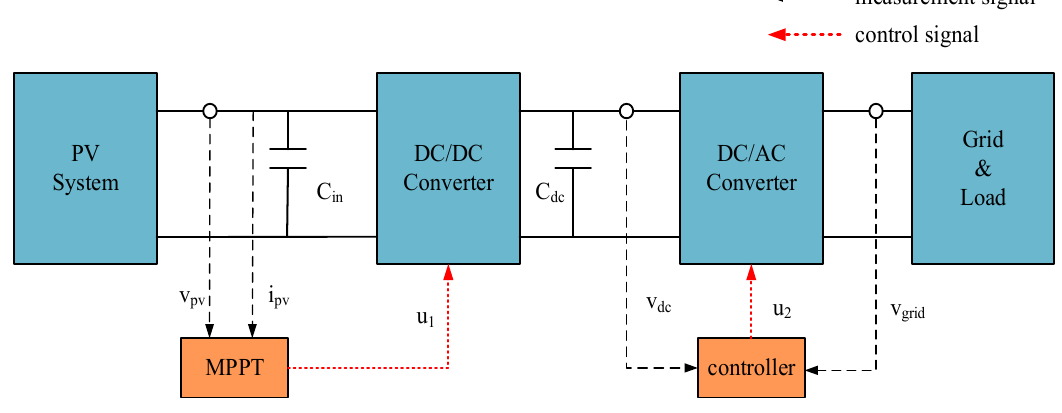
Figure 1. Typical structure of a two-stage photovoltaic (PV) system.